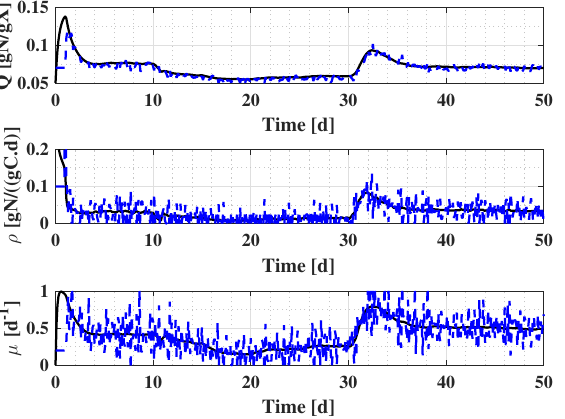
Figure 3. Time evolution of Q , ρ , and µ in black and their estimates provided by the AO and the 2 RELS in blue